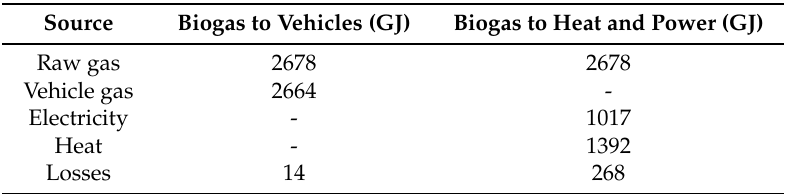
Table 4. Energy recovery in the second sensitivity analysis.